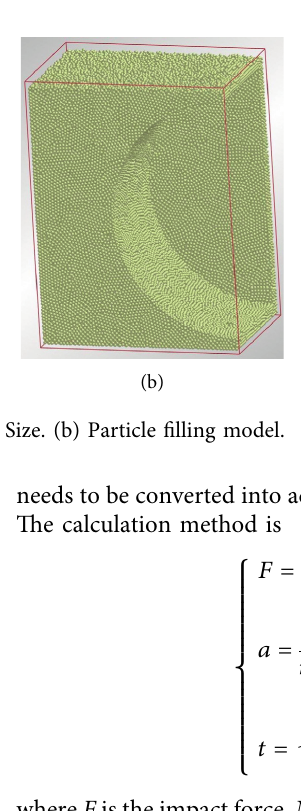
Figure 4: Distribution of pipes and interior structure of drum.